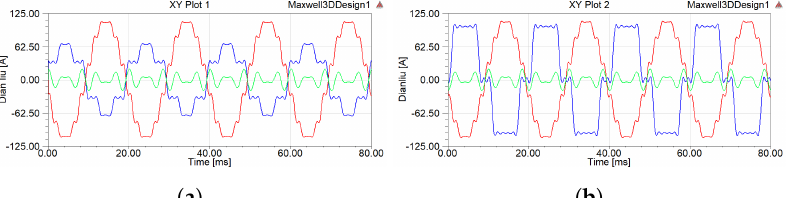
Figure 7. Current waveforms of grid-side and valve-side windings under working condition 2. ( a ) The left column. ( b ) The right column.